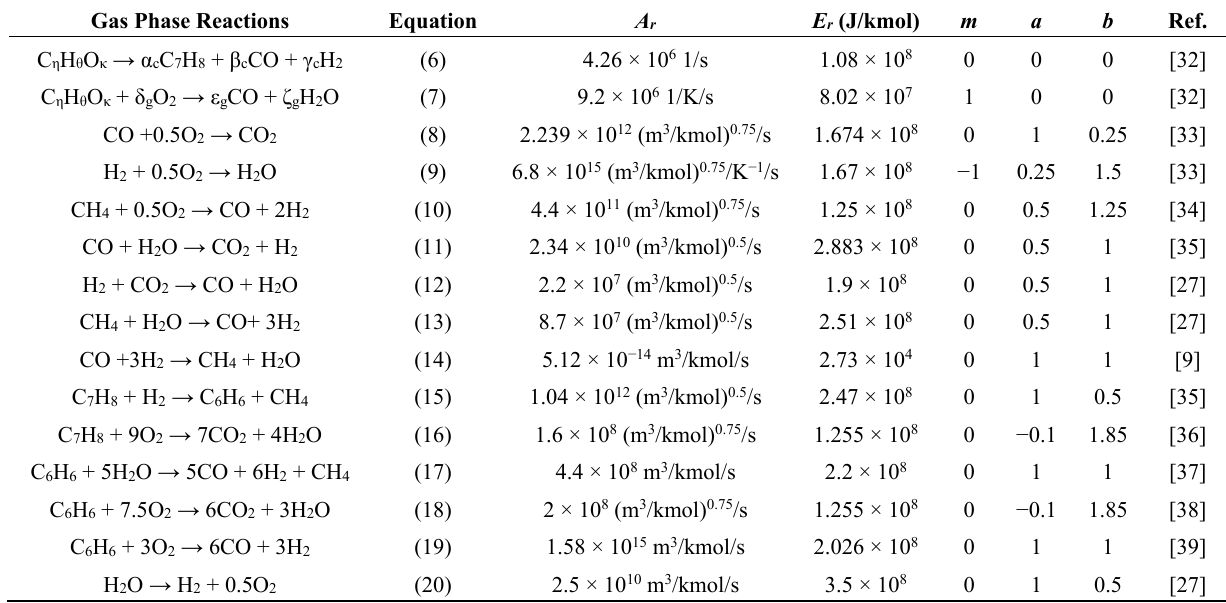
Table 2. Kinetic parameters for gas phase reactions.